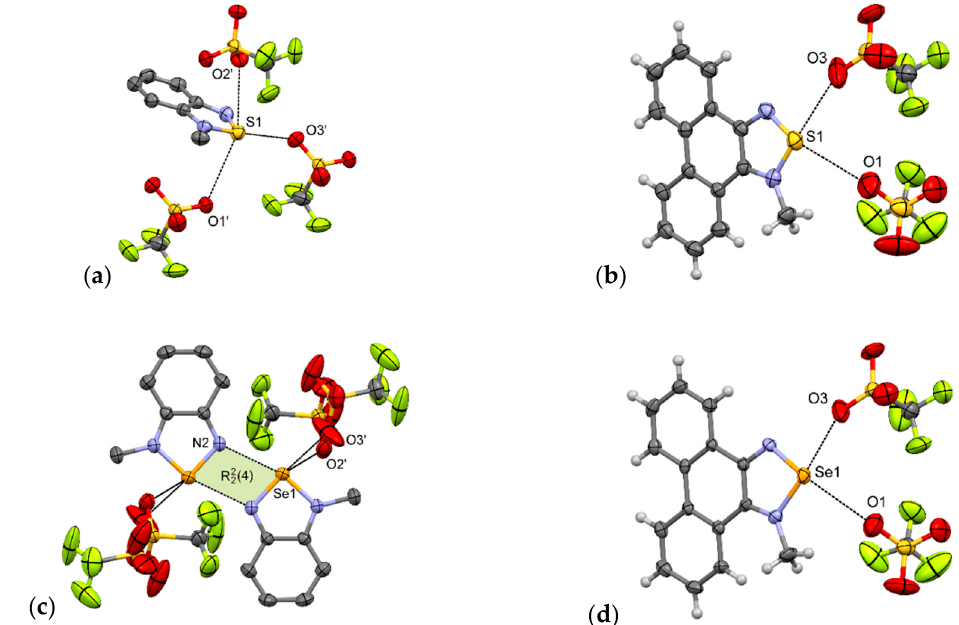
Figure 6. Arrangement of ions in the crystals of: ( a ) 1-MeTfO , ( b ) 2-MeTfO , ( c ) 3-MeTfO , and ( d ) 4-MeTfO (some hydrogen atoms are omitted for clarity).